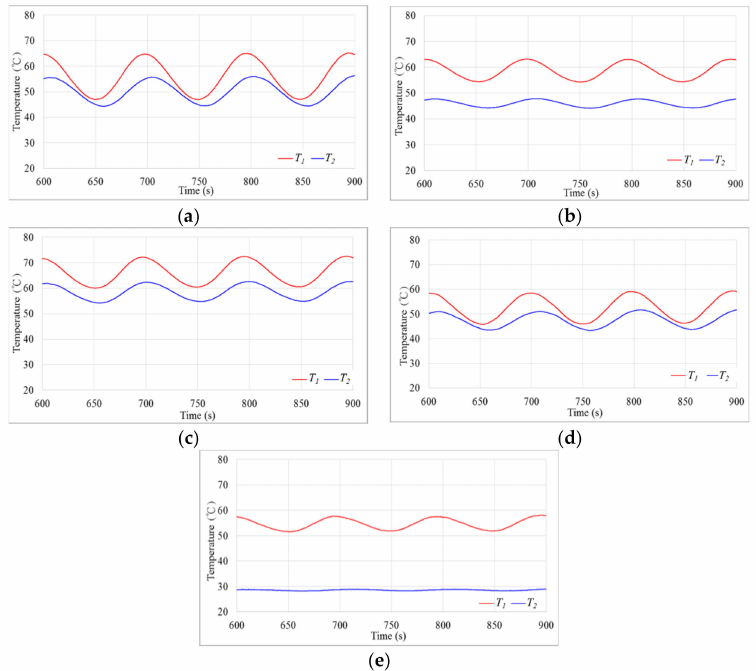
Figure 6. Setup: One-dimensional heat transfer measurement of the sample: ( a ) Location distribution of temperature measuring points; ( b ) Temperature measuring component.